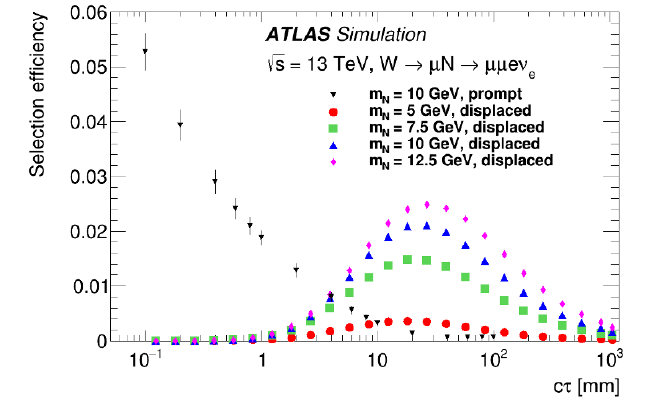
Figure 2. HNL search event selection e(cid:14)ciency as a function of mean proper decay length evaluated from simulation. The e(cid:14)ciency for the prompt signature in the muon channel is shown for an HNL mass of 10 GeV, while the e(cid:14)ciencies for the displaced signature are shown for four di(cid:11)erent HNL masses. Error bars represent MC statistical